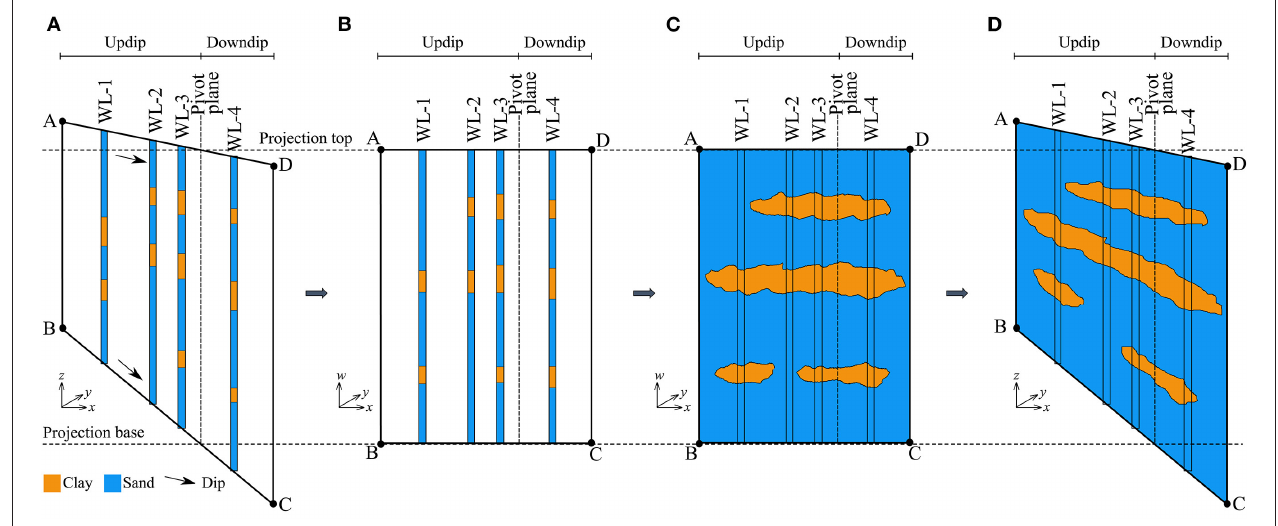
FIGURE 4 | A schematic of lithofacies modeling with domain translation and facies interpolation: (A) well logs in a dipping domain, (B) well logs in a non-dipping domain, (C) lithofacies modeling in the non-dipping domain, and (D) the stratigraphy model in the dipping domain.